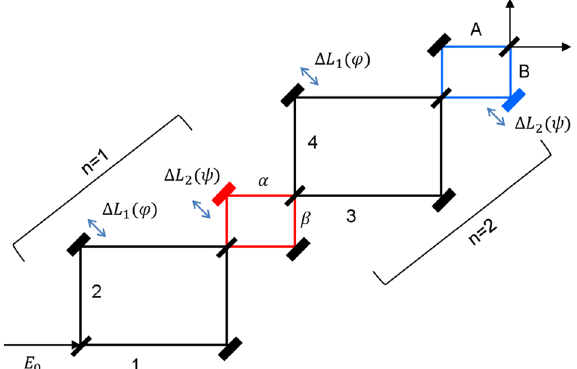
Figure 1. Schematic of macroscopic entanglement generation via path superposition of coupled interferometers. ϕ = 2 π (cid:31) � L 1 ; ψ = 2 π (cid:31) � L 2